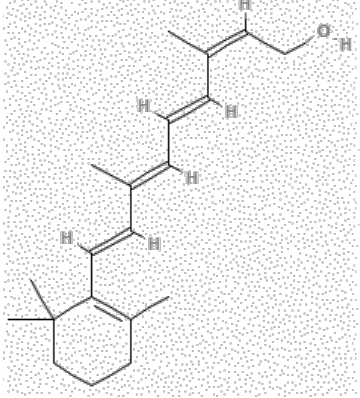
Figure 1. Chemical structure of isotretinoin (ITN).